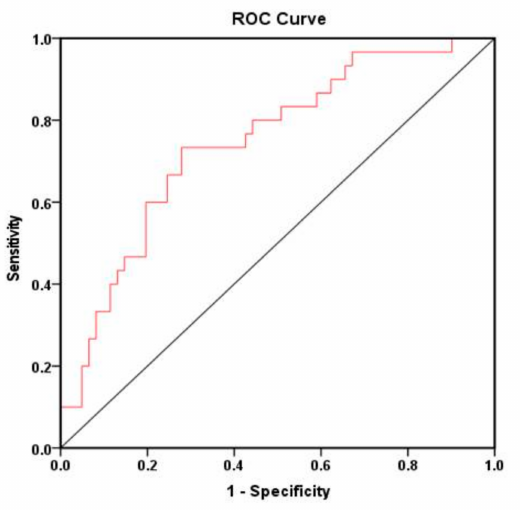
Figure A2. The ROC curve for the values of the DEI Score in the training cohort according to HFR during the 6 months from the first episode of HFpEF. AUROC = 0.746, 95% CI (0.640–0.853), p = 0.0001.